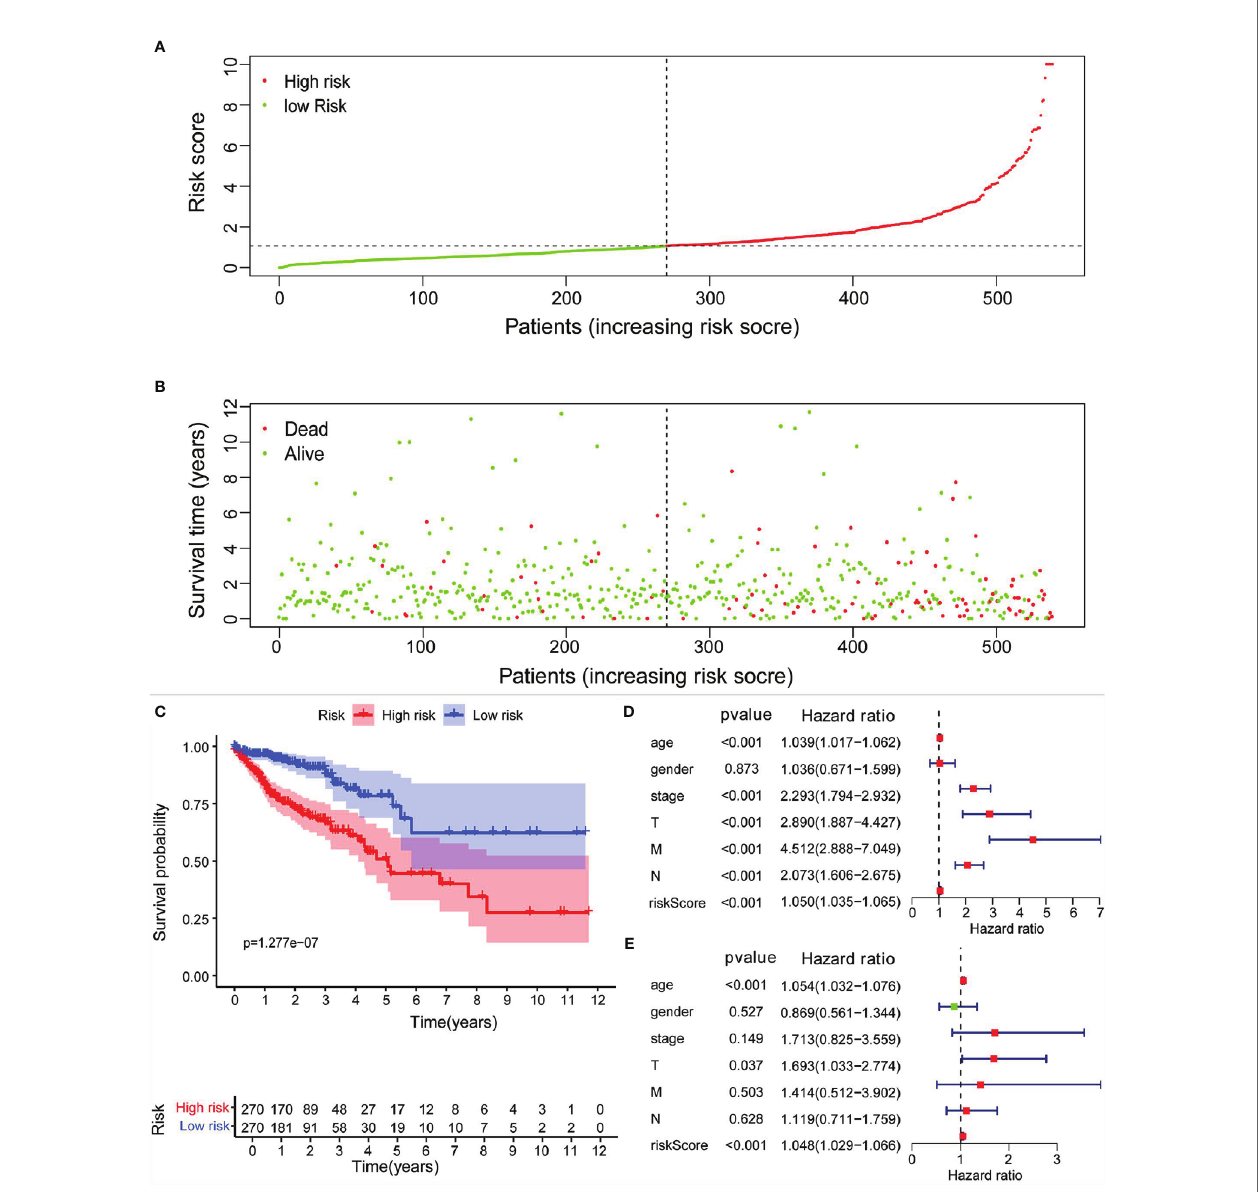
FIGURE 2 | (A) Risk scores for all samples from clinical data. (B) Distribution of risk scores and survival time of patients. (C) KM assessment of survival time for samples from TCGA clinical data using the autophagy prognostic model. Forest plot of (D) univariate and (E) multivariate independent prognostic analysis of the